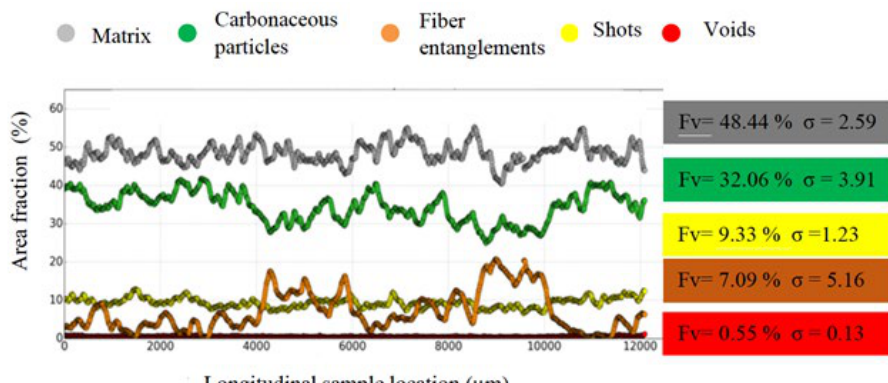
Figure 7. Spatial constituents’ distributions according to the longitudinal location (Z-axis) along the sample in M1, with the volume fraction (Fv) and standard deviation ( σ ) of each constituent.